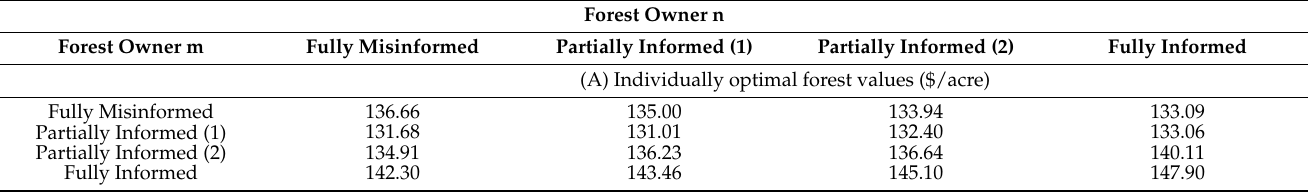
Table 4. Optimal solutions with regulated fuel stock for forest owner m for different misinformation